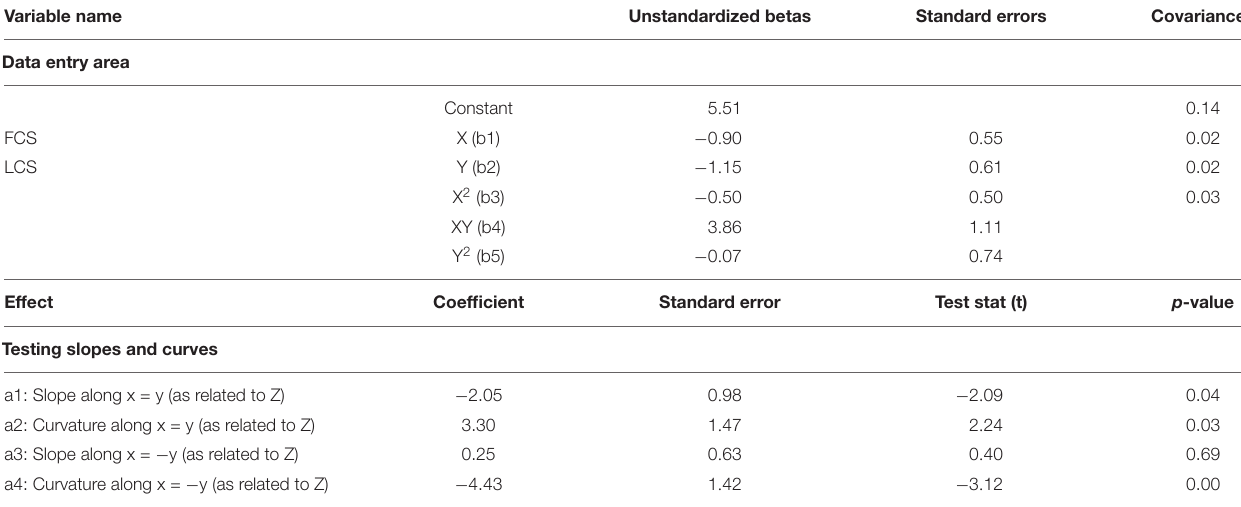
TABLE 4 | The relationship between cognitive similarity in leader-follower dyad and followers’